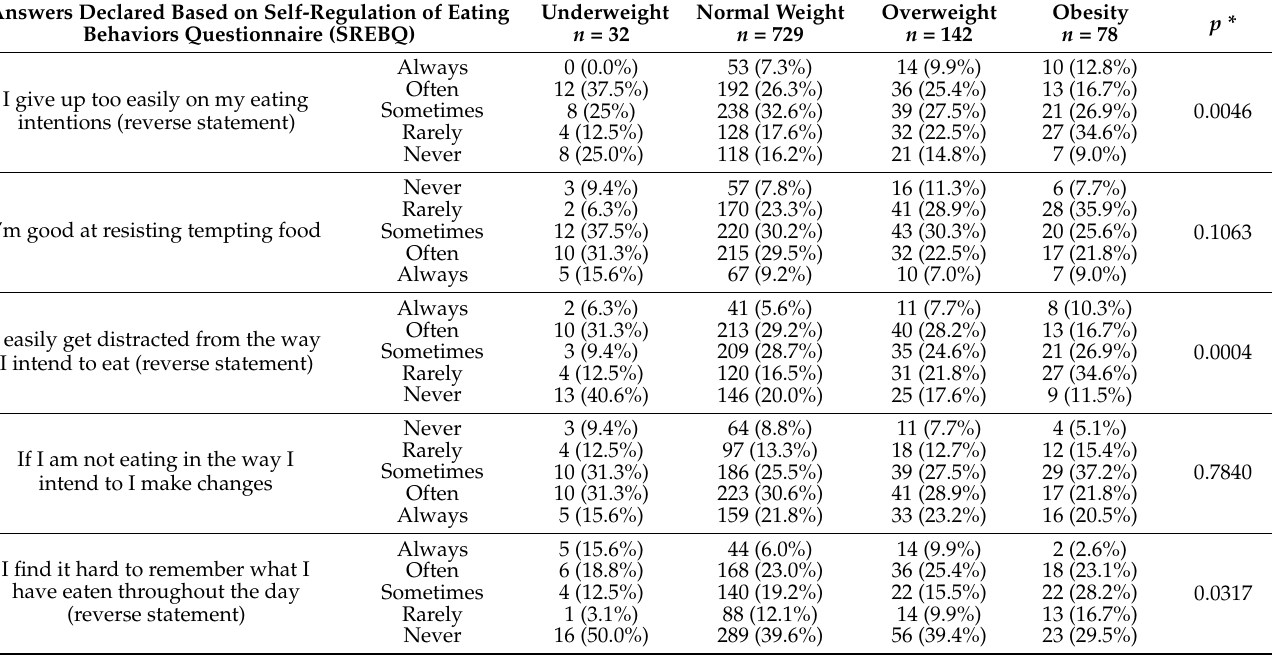
Table 4. The self-regulation of eating behaviors assessed using the Self-Regulation of Eating Behaviour Questionnaire (SREBQ), within the Polish Adolescents’ COVID-19 Experience (PLACE-19) Study ( n = 981) in subsamples stratified by body mass